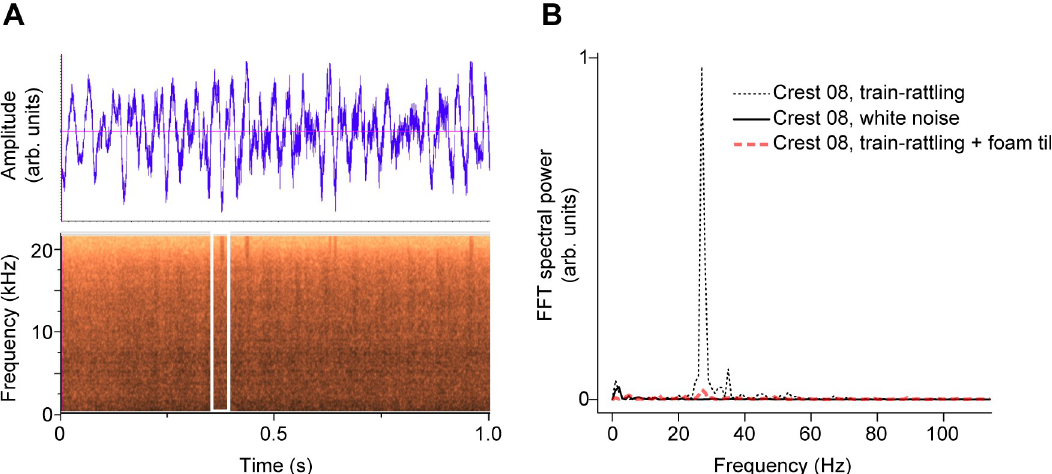
Fig 5. Effect of audio playback on crests. (A) An example waveform and spectrogram of the train-rattling sound used in the playback experiment. The white box in (B) highlights a single rattle note in the train-rattling spectrogram. (B) Vibrational response of a peahen crest (Crest 08) exposed to audio playback in the near-field of the speaker. The FFT spectral power during playback of train-rattling sound (dotted line, plotted on a linear scale on the y-axis) has a peak near the resonant frequency of the crest. The spectral power values recorded during white noise playback (solid line) and when the train-rattling audio was blocked by a foam tile (red dashed line) are also